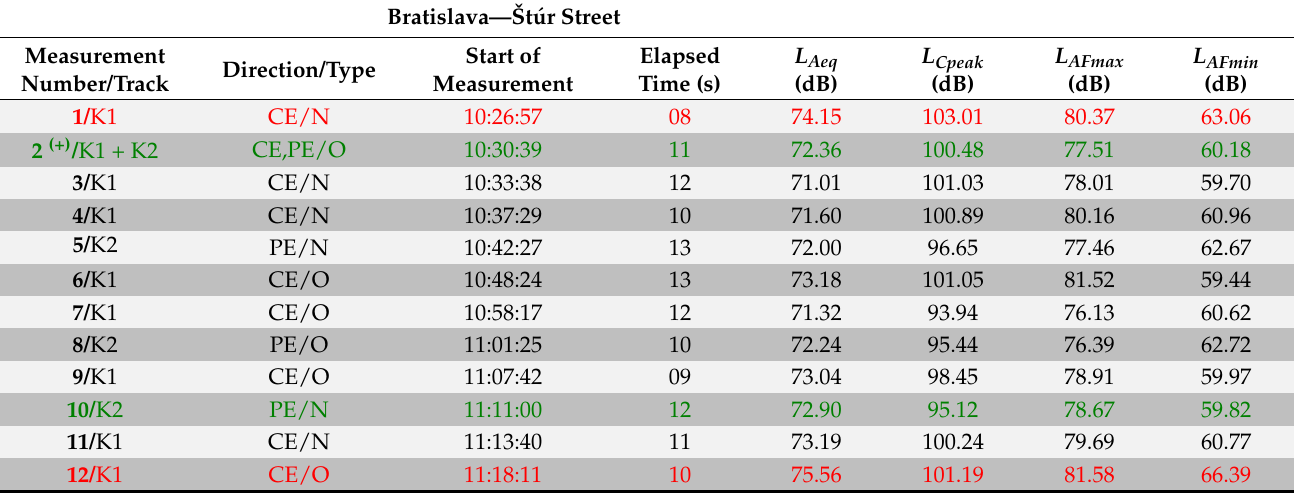
Table 2. Time history of measurements and overview of values of measured quantities of the whole record in B1H .